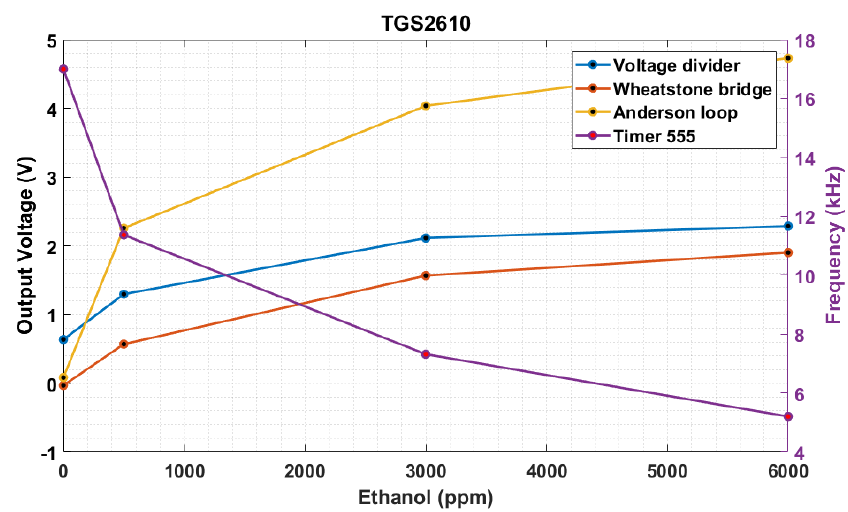
Figure 15. Value of second slope measured with the TGS 2610 in the rising edge.